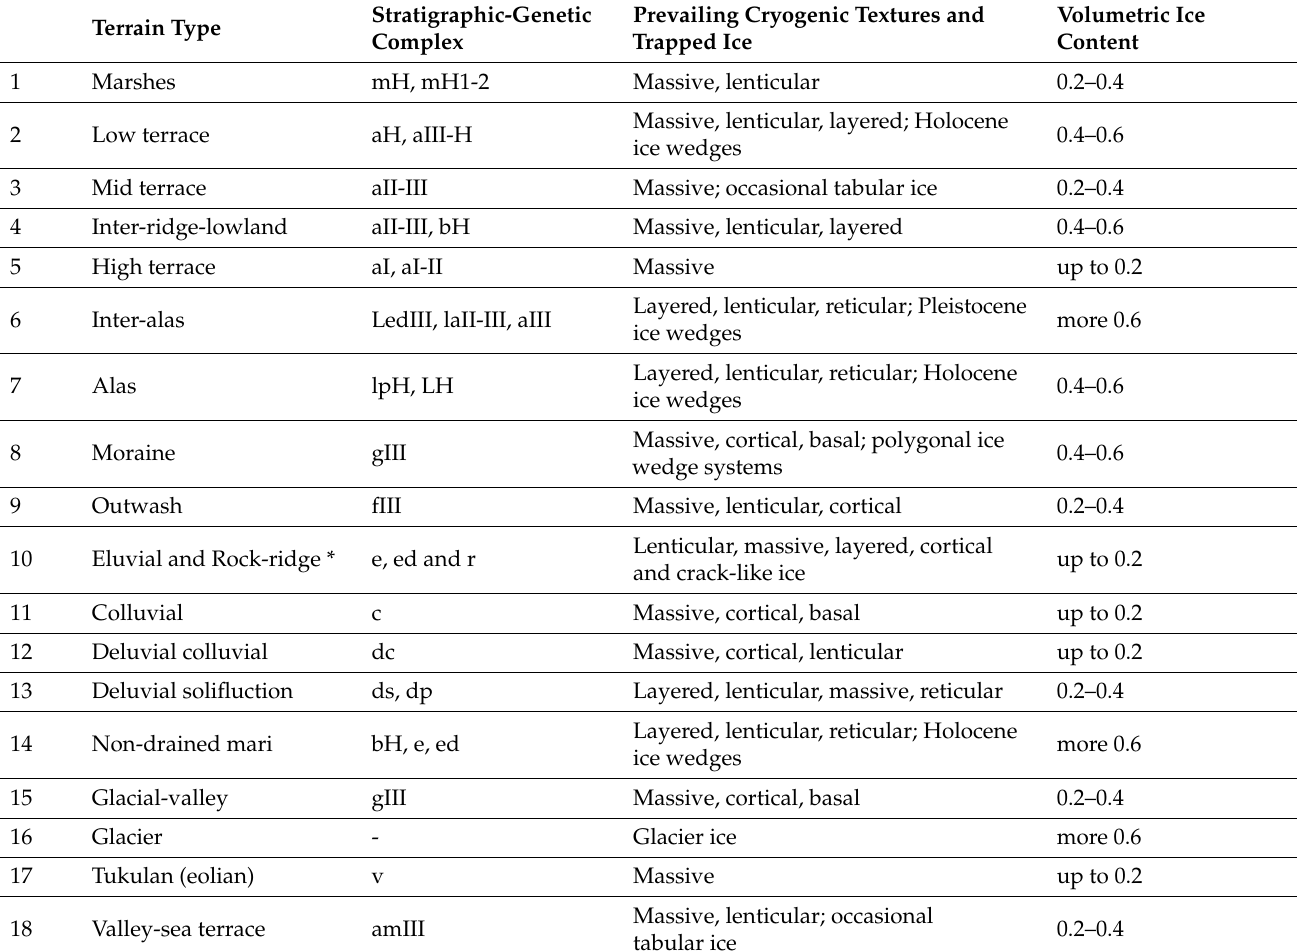
Table 1. Prevailing cryostructure and Volumetric ice content in terrain types, Arctic